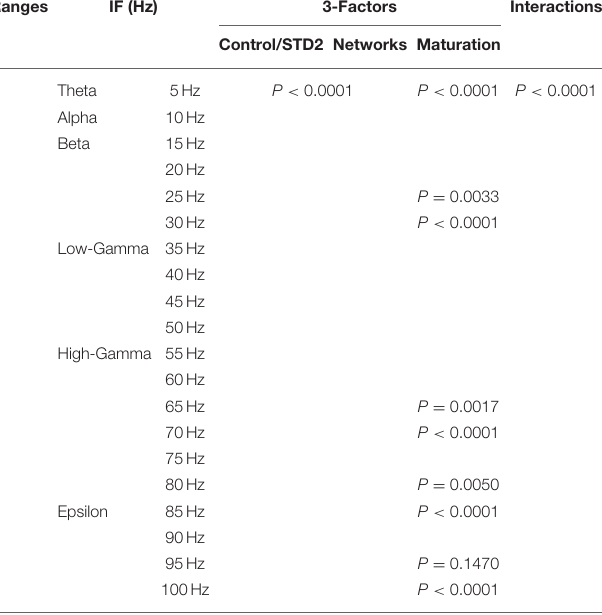
TABLE 3 | Three-way ANOVA for